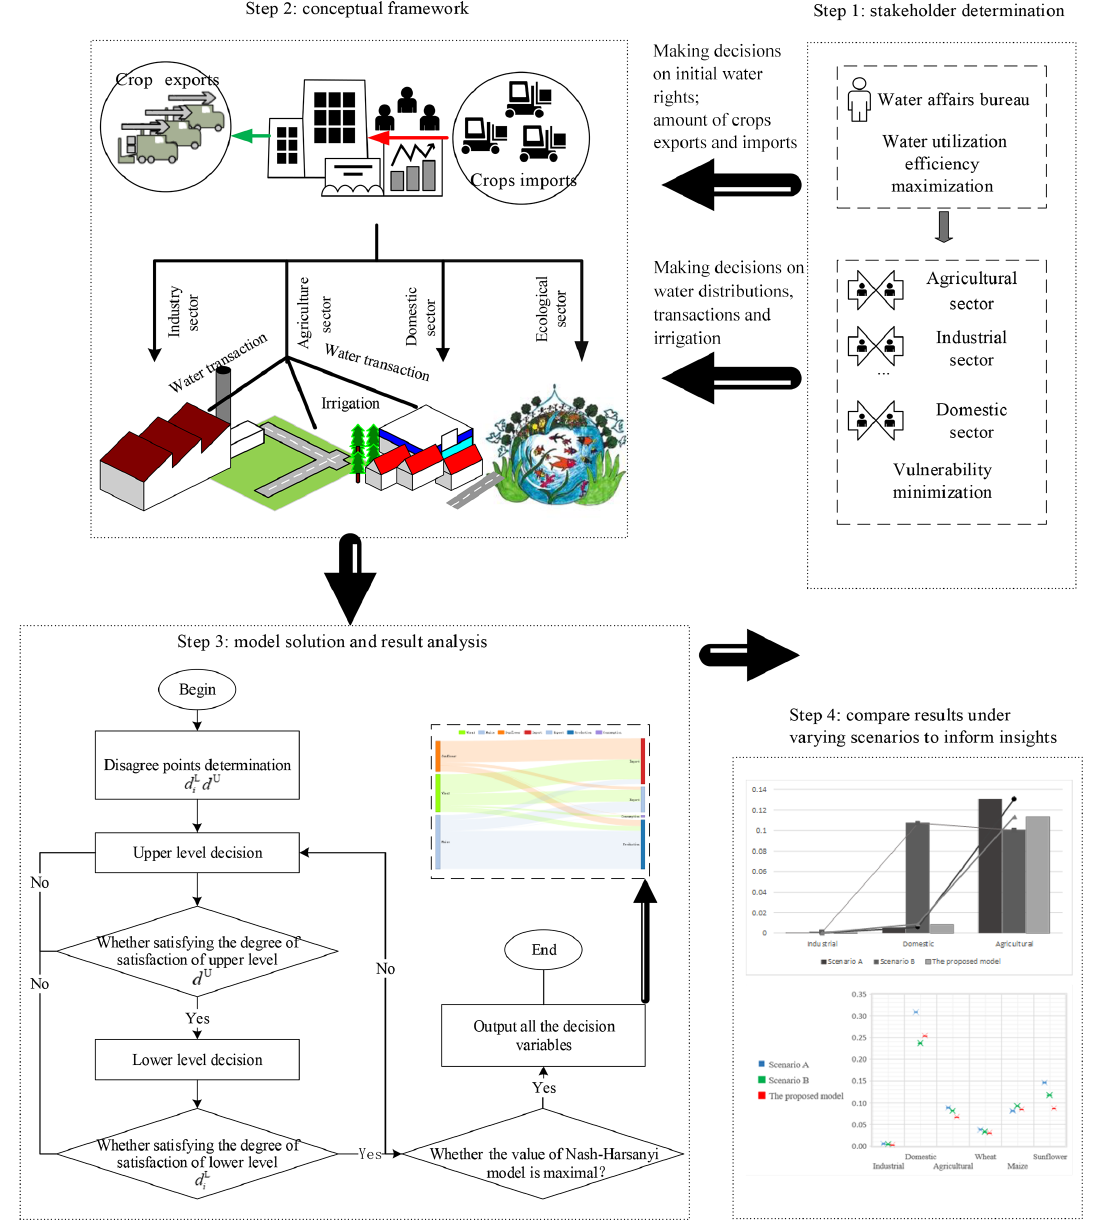
Figure 2. Four steps in the water allocation plan and future